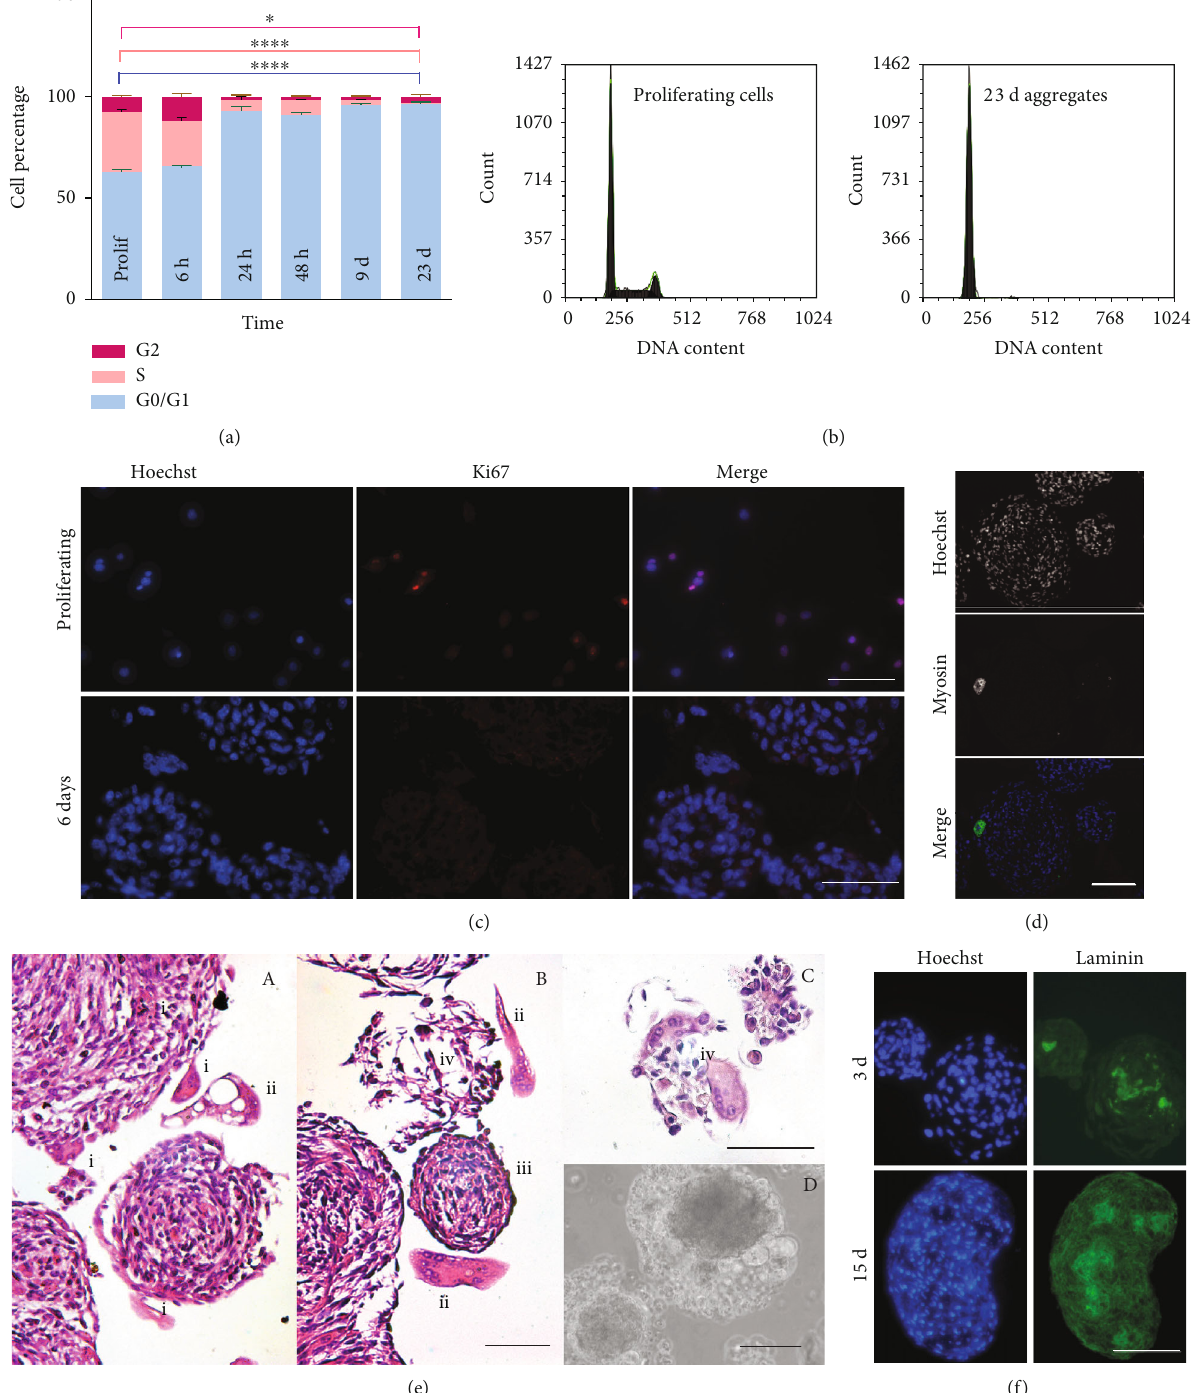
Figure 2: Characterization of C2C12 myospheres. (a) Bar chart from cyto fl uorometer data showing the proportion of cells ( ± SD) in di ff erent phases of the cycle, in a monolayer and in myospheres of di ff erent ages. ∗ 0 : 01 < p < 0 : 05 and ∗∗∗∗ p < 0 : 0001 . (b) Cyto fl uorometer plot comparing the cell cycle in cells proliferating in a monolayer and in 23-day myospheres. (c) Ki67 expression in a monolayer and 6-day myospheres. (d) Myosin expression evaluated by immuno fl uorescence. A labelled syncytium is at the periphery of a 9-day myosphere. (e) H&E staining of 9-day myospheres containing di ff erentiating cells. Syncytia leaving the myospheres or internally located are indicated with (i), syncytia isolated in the medium after exit from a myosphere with (ii). (iii) indicates a mature myosphere that does not appear to contain syncytia. (e) in B and C, the symbol (iv) labels small myospheres dissolving after the detachment of syncytia. (f) Accumulation of extracellular matrix proteins in myospheres over time. Laminin expression in 3-day and 12-day myospheres. Scale bar: 50 μ m in (c), (d), and (f) and 100 μ m in